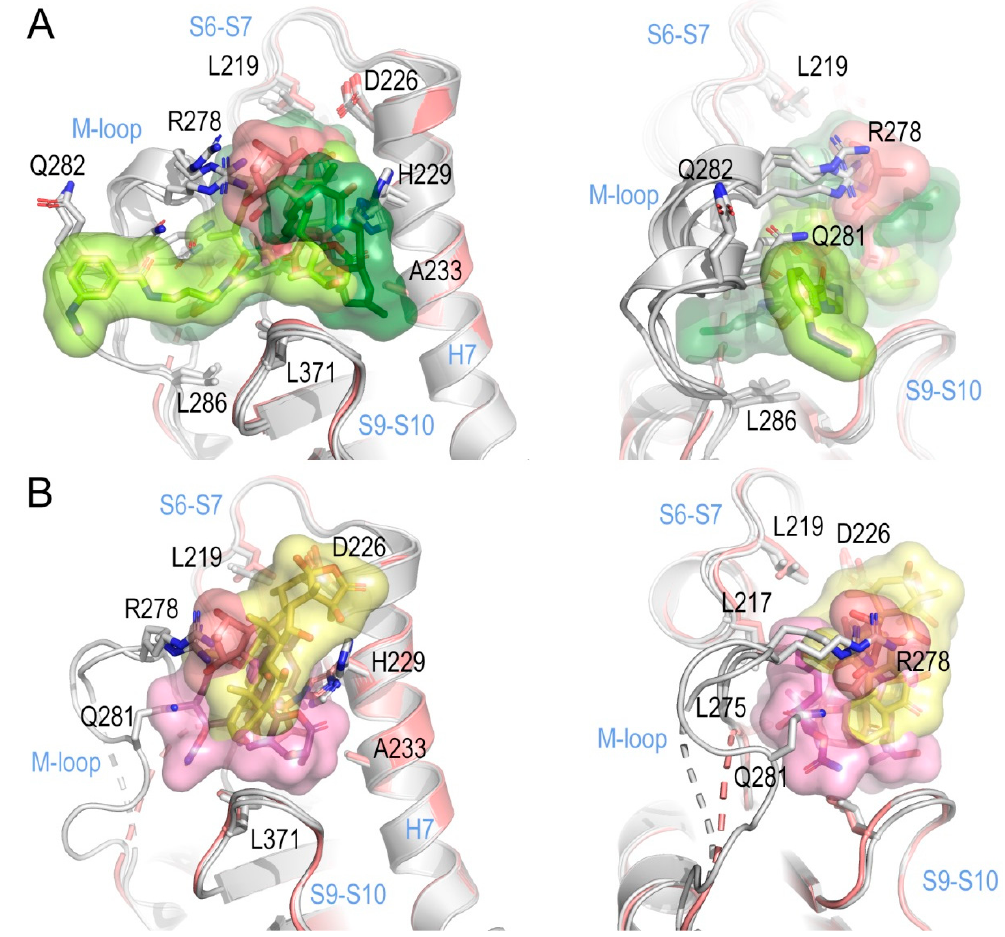
Figure 4. M-loop structuring by taxane-site binding agents. ( A ). Superposition of the T2R-TTL-cyclosteptin structure (6QTN, salmon) onto the taxane-sites of the corresponding T2R-TTL-zampanolide (dark green, 4I4T, chain D, rmsd 0.175 Å, 371 C α atoms), -epothilone (pale green, PDB ID 4I50 on chain D, rmsd 0.234 Å, 358 C α atoms) and -DDM-paclitaxel hybrid KS-1-199-32 (lime green, 5LXS on chain D, rmsd 0.159 Å, 348 C α atoms) complexes, highlighting the structuring of the M-loop into a helical conformation in two orientations. ( B ) Superposition of the T2R-TTL-cyclosteptin structure (salmon) onto the taxane-sites of the corresponding T2R-TTL-DDM (pink, PD 5LXT on chain D, rmsd 0.152 Å, 378 C α atoms) and –taccalonolide AJ (yellow, 5EZY on chain D, rmsd 0.187 Å, 369 C α atoms) complexes, highlighting partial structuring with no detectable helical conformation. The backbones of the proteins are displayed in ribbon; the ligands are in stick and semi-transparent surface representation, respectively. Key interacting residues and secondary structural elements discussed in the text are labeled in black and blue, respectively.